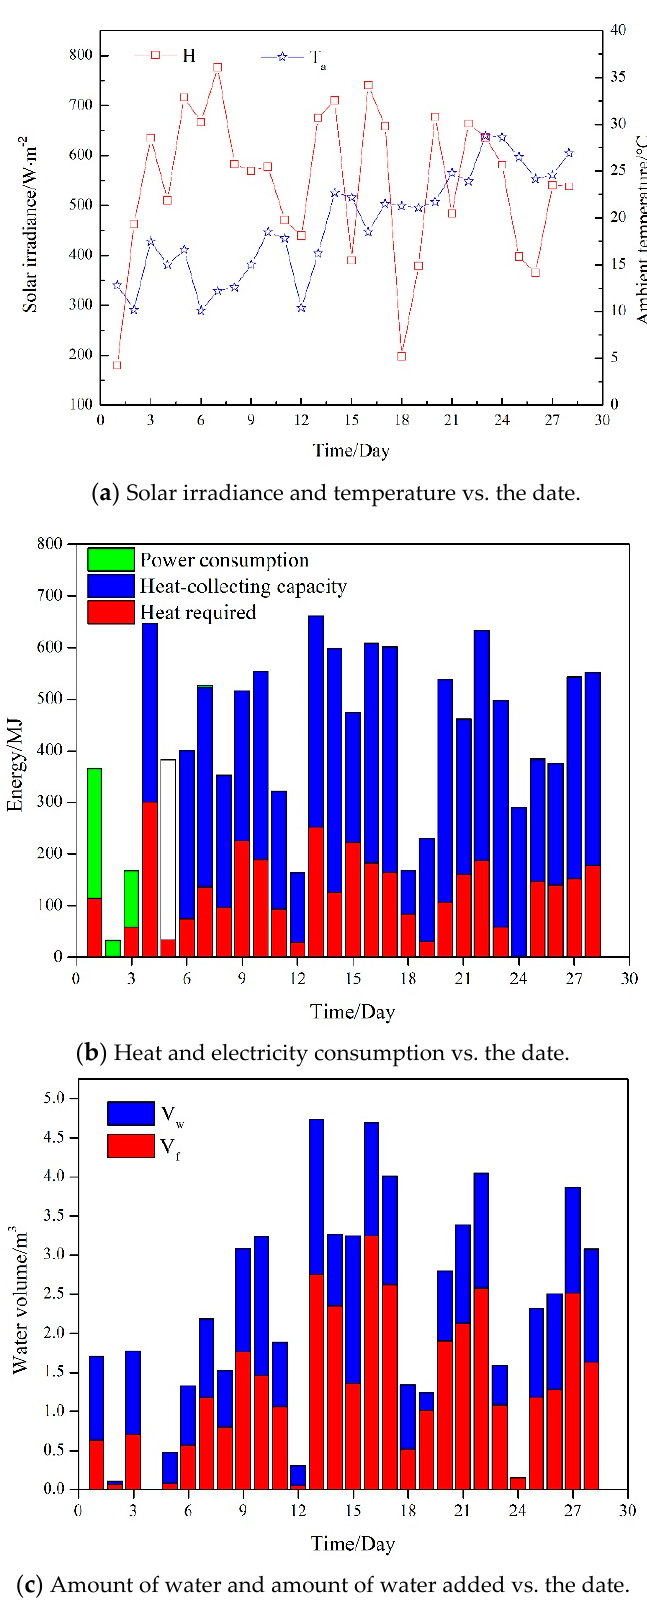
Figure 4. Change of each index in April.